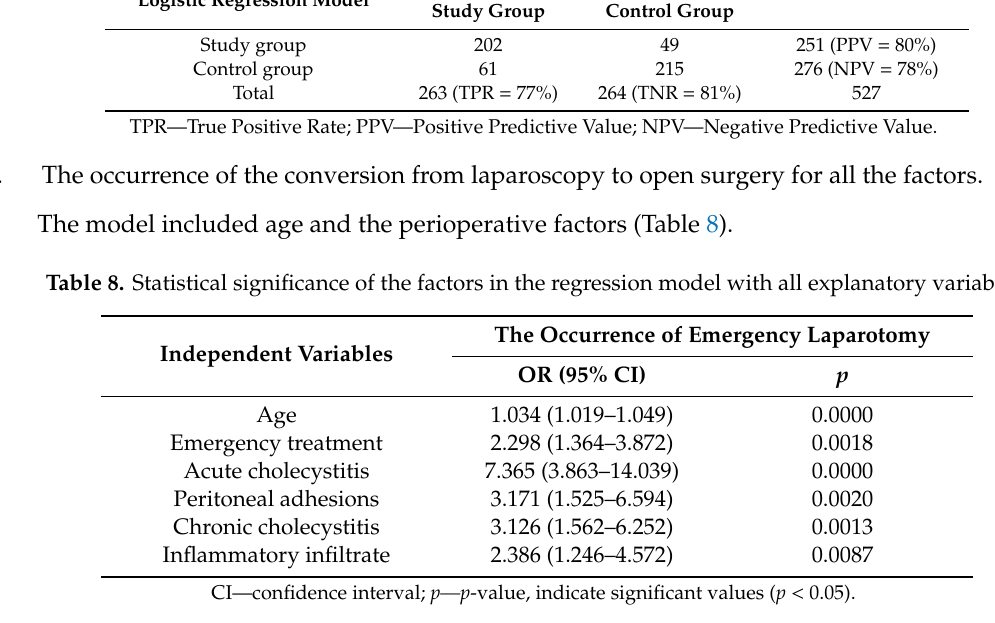
Table 7. Results of the classification of patients in the studied population. Classification Based on the Logistic Regression Model